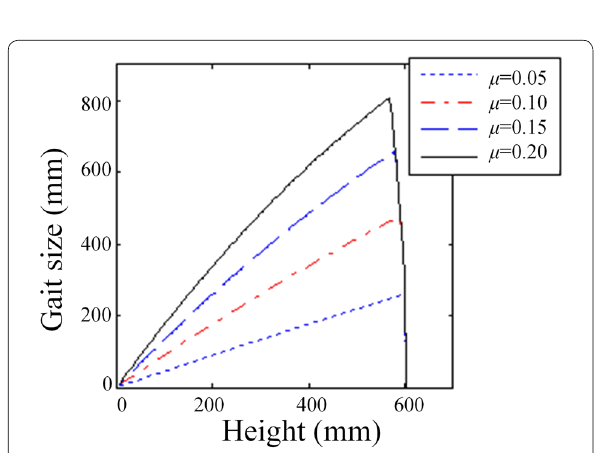
Figure 18 Maximum stride length under different friction